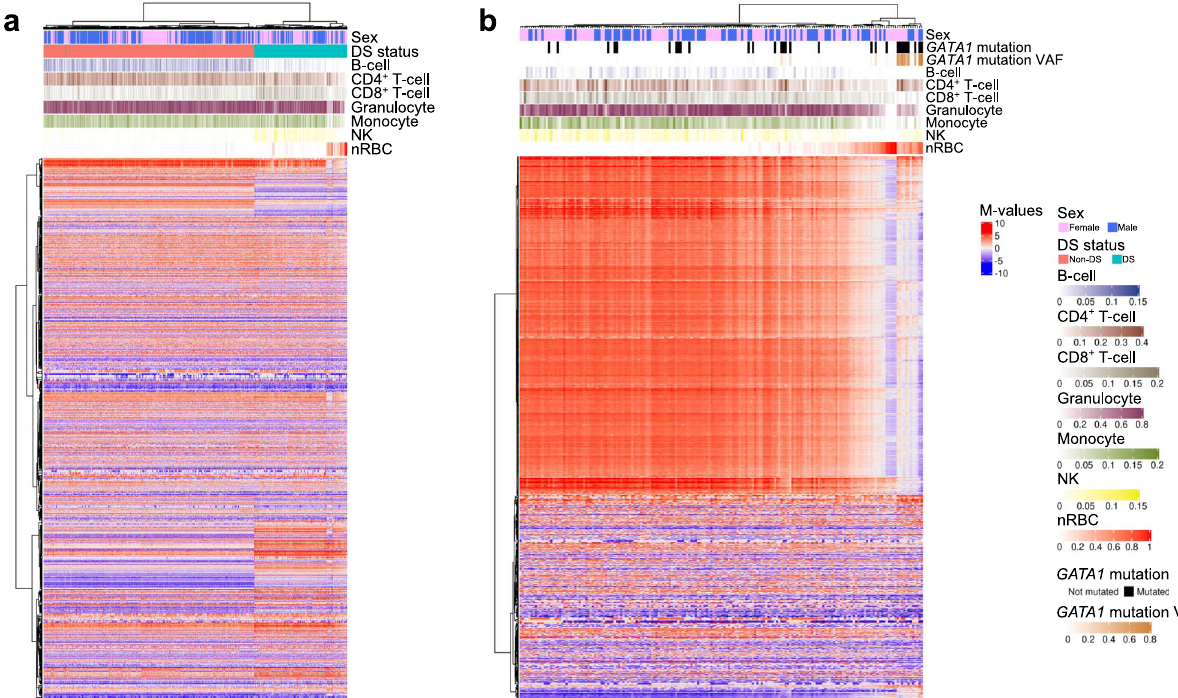
Fig. 2 Heatmap and unsupervised hierarchical clustering of the top 2000 most variable CpGs genome-wide in Down syndrome (DS) and non-DS newborns, and by GATA1 mutation status. These plots were generated using genome-wide DNA methylation data excluding chromosomes X, Y, and 21, and with β values converted to M values, using the “ ComplexHeatmap ” R package. Only the top 2000 CpGs with the greatest mean absolute deviation are displayed. a Hierarchical clustering and heatmap of 196 DS and 439 non-DS newborns, in relation to subject sex and deconvoluted blood cell proportions of B cells, CD4 + T cells, CD8 + T cells, granulocytes, monocytes, natural killer (NK) cells, and nucleated red blood cells (nRBCs). The fi rst separation in hierarchical clustering represented DS (teal) versus non-DS (red) newborns. Two DS newborns clustered with the non-DS newborns, and were the same as those that clustered similarly in the t-SNE plot in Fig. 1. The DS newborns clustered into two main subgroups, those with high nRBC proportions and those with low nRBC proportions. b Hierarchical clustering and heatmap of 184 DS newborns, including 30 found to harbor somatic GATA1 mutations via targeted sequencing, and 154 found to be GATA1 mutation wildtype. DS newborns with GATA1 mutations are represented by black bars, and the variant allele frequency (VAF) range of mutations shown in the row below. The fi rst split appeared to separate DS newborns with high nRBC proportions from those with low nRBC proportions, whereas the second split was largely driven by subjects with GATA1 mutations with high VAF. DS newborns with GATA1 mutations with high VAF clustered together and tended to have high nRBC proportions; however, a proportion of GATA1 wild-type newborns were also found to have high nRBC proportions, and these also clustered